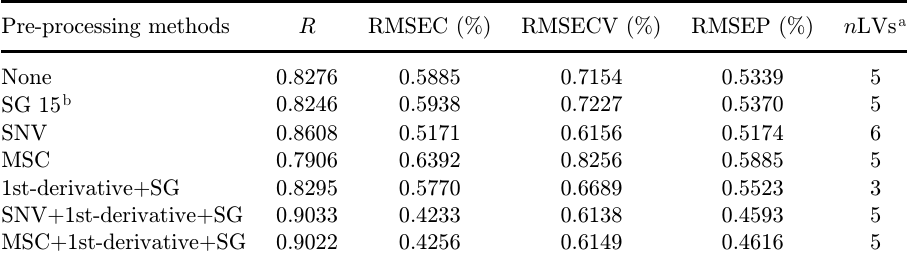
Table 2. Model results with di®erent pre-processing methods. Pre-processing